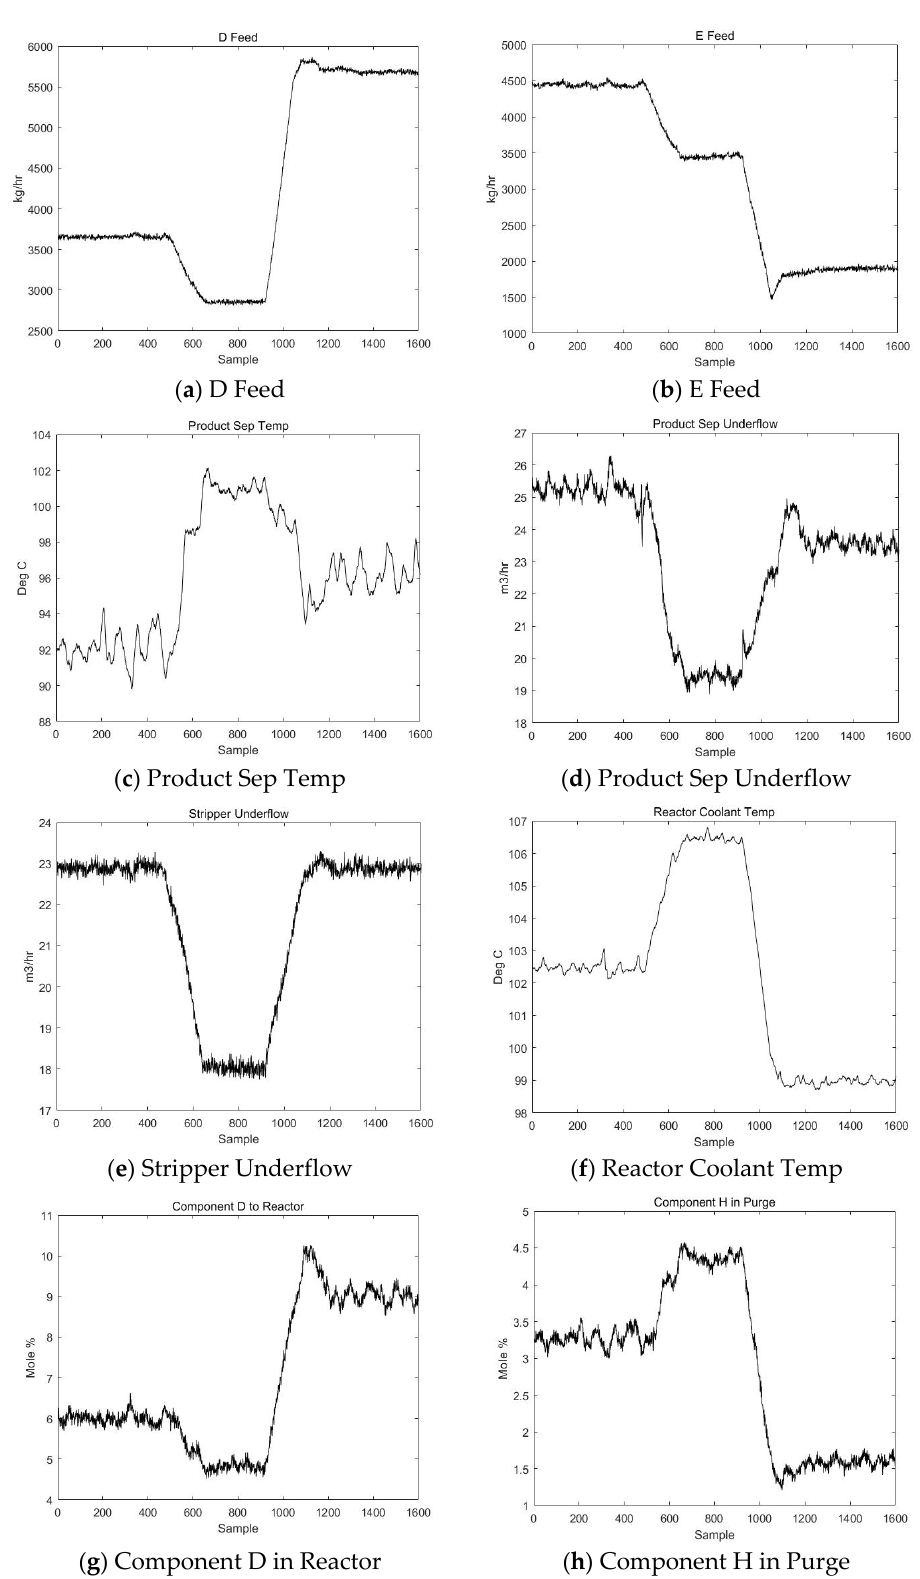
Figure 4. The change curves of the 8 variables of the simulation data.